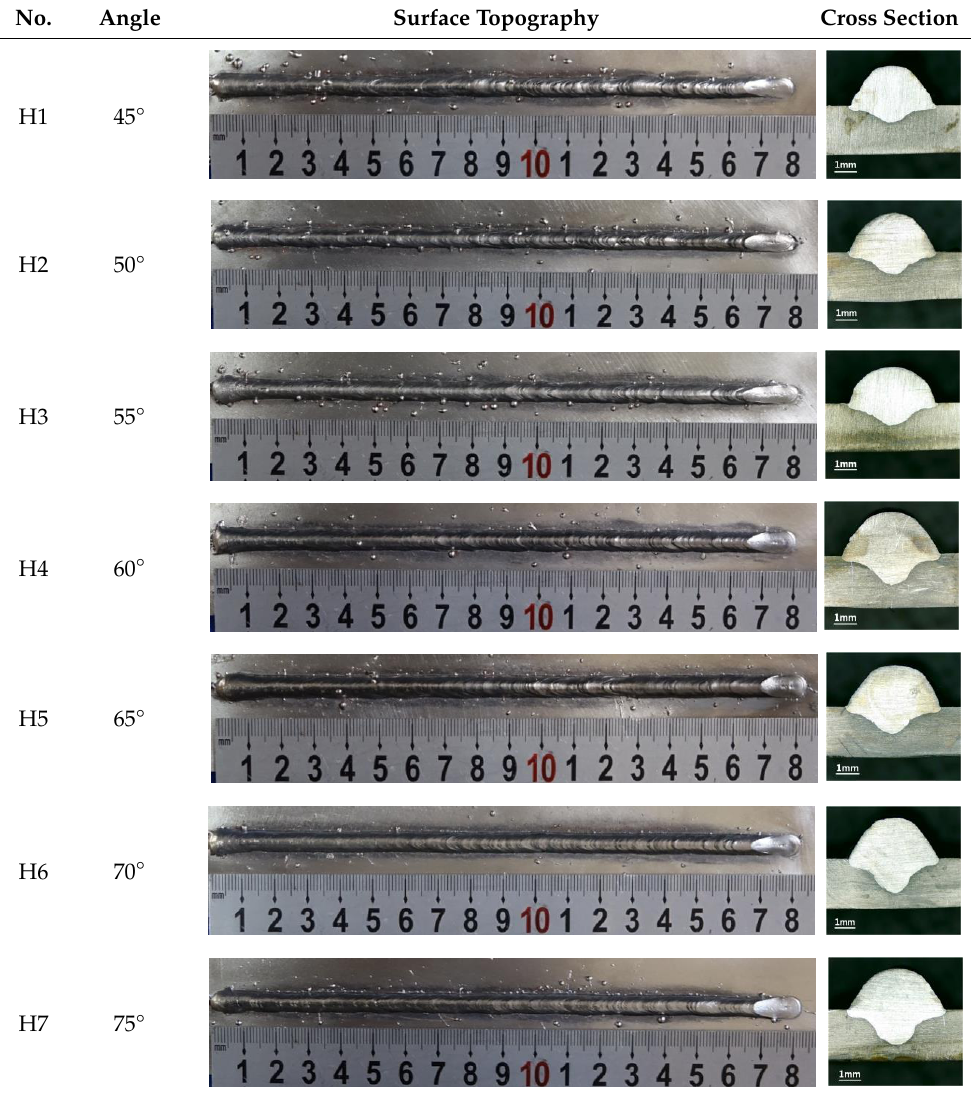
Cross Cross Section